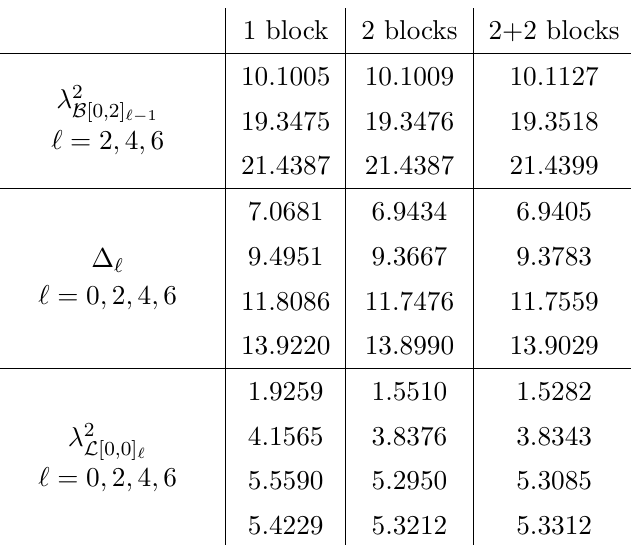
Table 4. Crude estimates of unprotected CFT data of A 1 theory for the first few lowest spins. The results are obtained by imposing λ 2 = 0 and approximating the entire unprotected part of D [0 , 4] a ( z, ¯ z ) by: a single scalar block on the leading long trajectory (“1”), one block of spin 0 and one block of spin 2 on the leading long trajectory (“2”), and blocks of spin 0 and spin 2 both on the leading and subleading long trajectories (“2+2”). The input CFT data are listed in